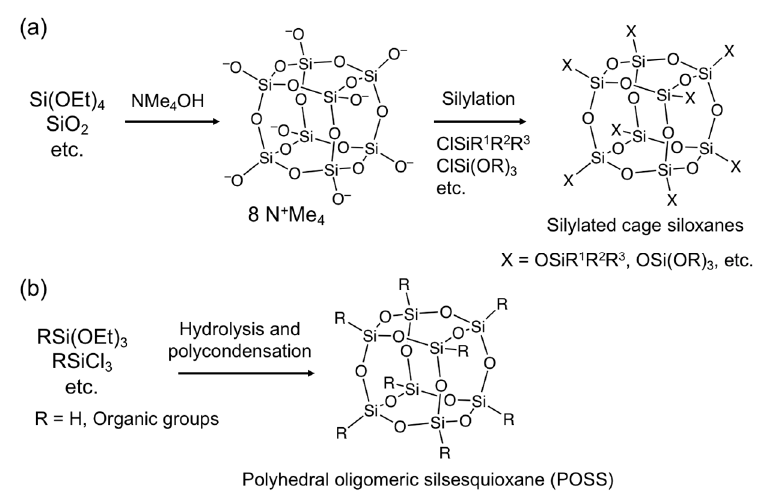
Figure 2. General synthetic routes to cage-type oligosiloxanes with a D4R structure. ( a ) Synthesis of D4R silicate anions using TMAOH and subsequent silylation with chlorosilane to introduce functional groups; ( b ) Synthesis of POSSs.